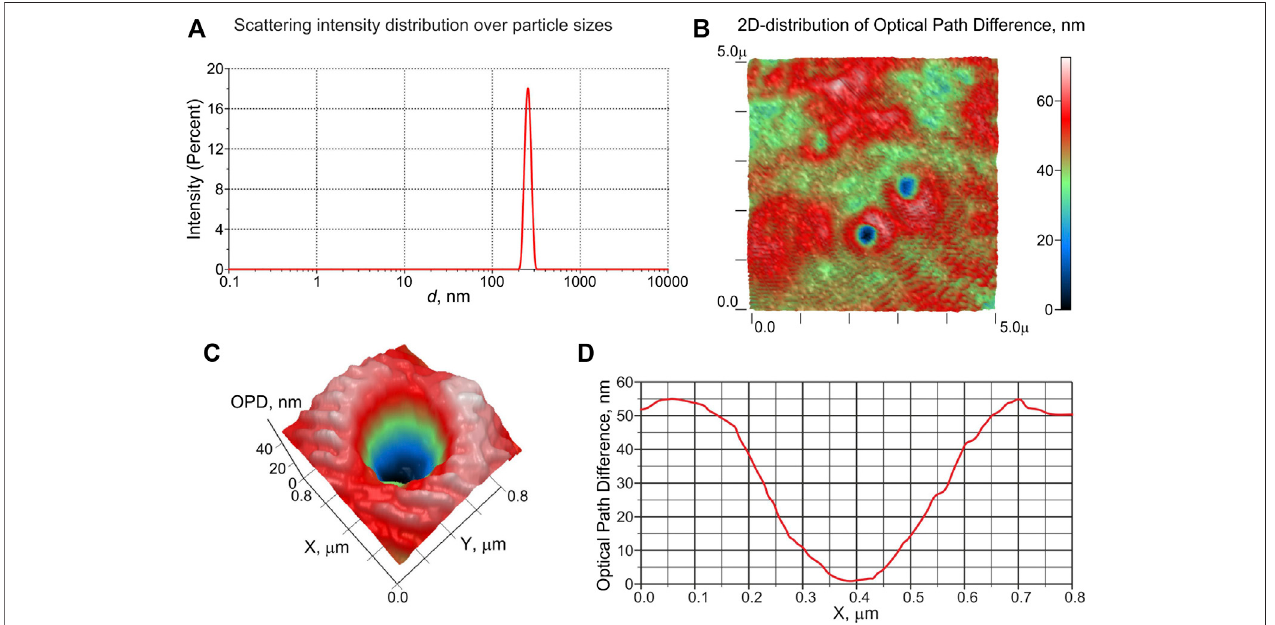
FIGURE 6 | Results of the experiments with DLS and LPM for physiological solutions, saturated with CO 2 under a pressure of 3 atm. Panel (A) : distribution of scattering intensity over scatterer sizes in the DLS experiment. Panel (B) : colormap of 2D distribution of the optical path difference (OPD) of a sample area (5 × 5 μ m 2 ); objects of 300 – 400 nm in size, for which the OPD distribution has a concave pro fi le, are clearly visible. Panel (C) : 2D distribution of OPD in the vicinity of an object with a concave OPD. Panel (E) : 1D pro fi le of OPD across the object shown in panel (C) ; according to the calibration data, the refractive index of this object is n ≈ 1.03, i.e., it is gas nanobubble.